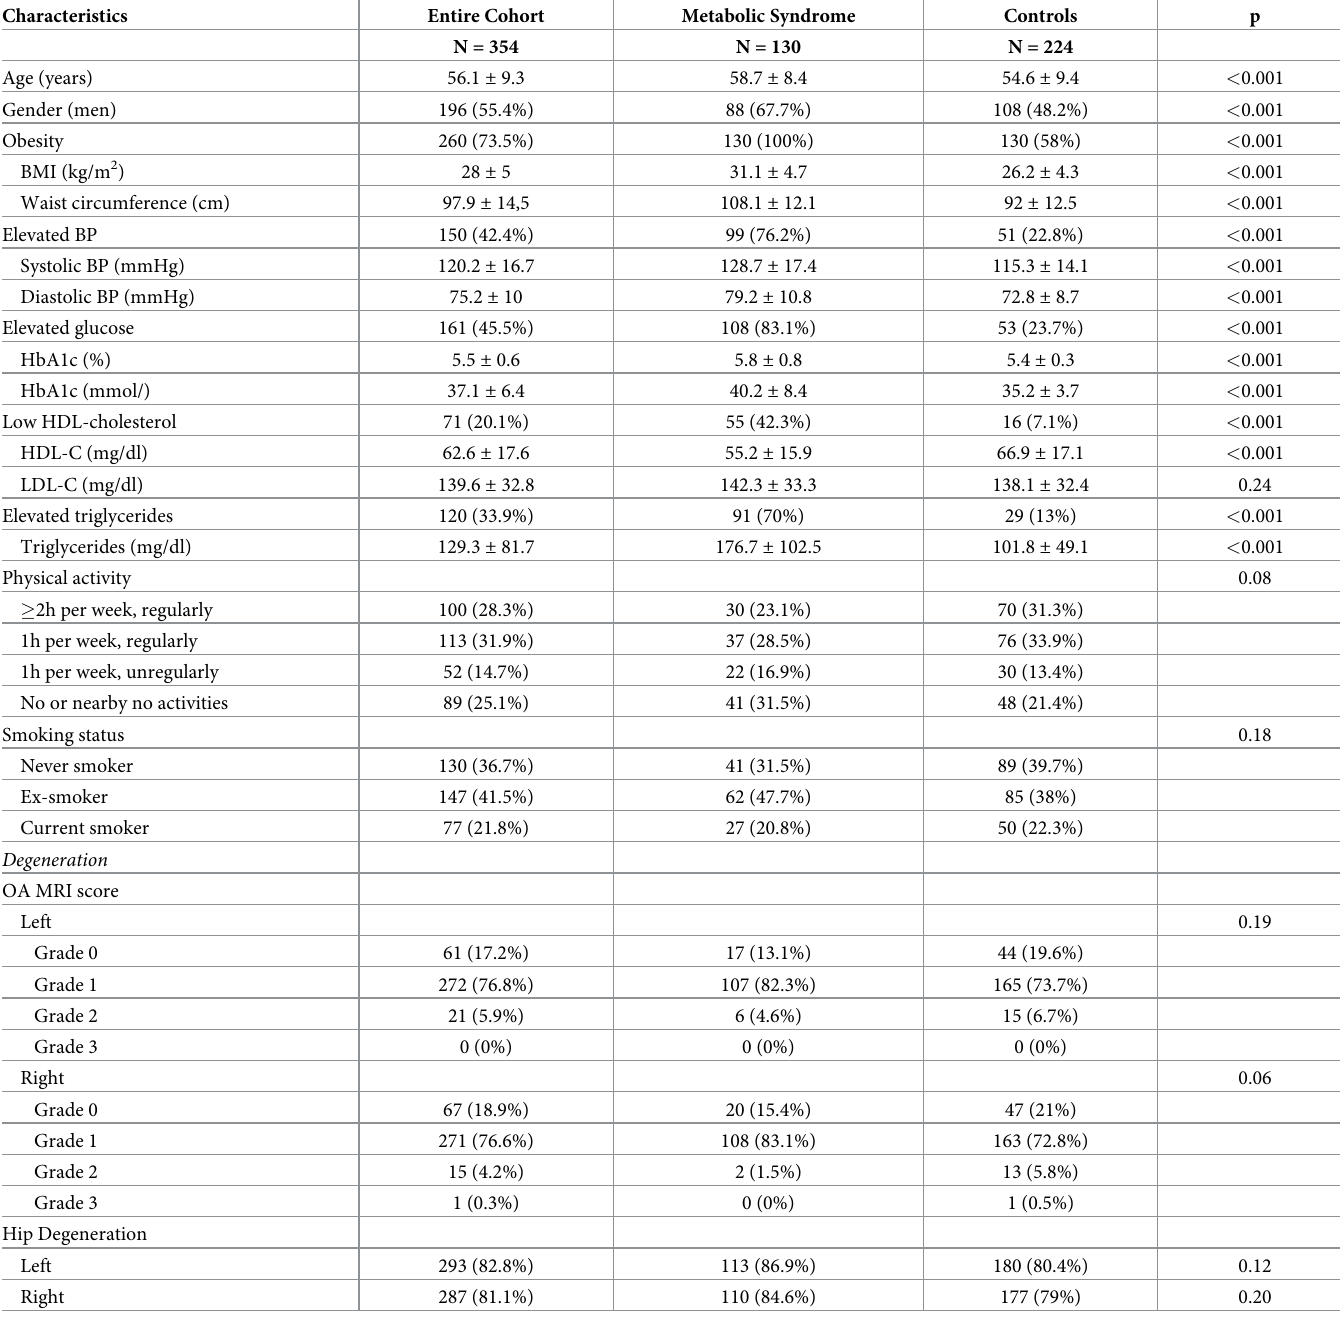
Table 1. Demographics and risk factors for hip